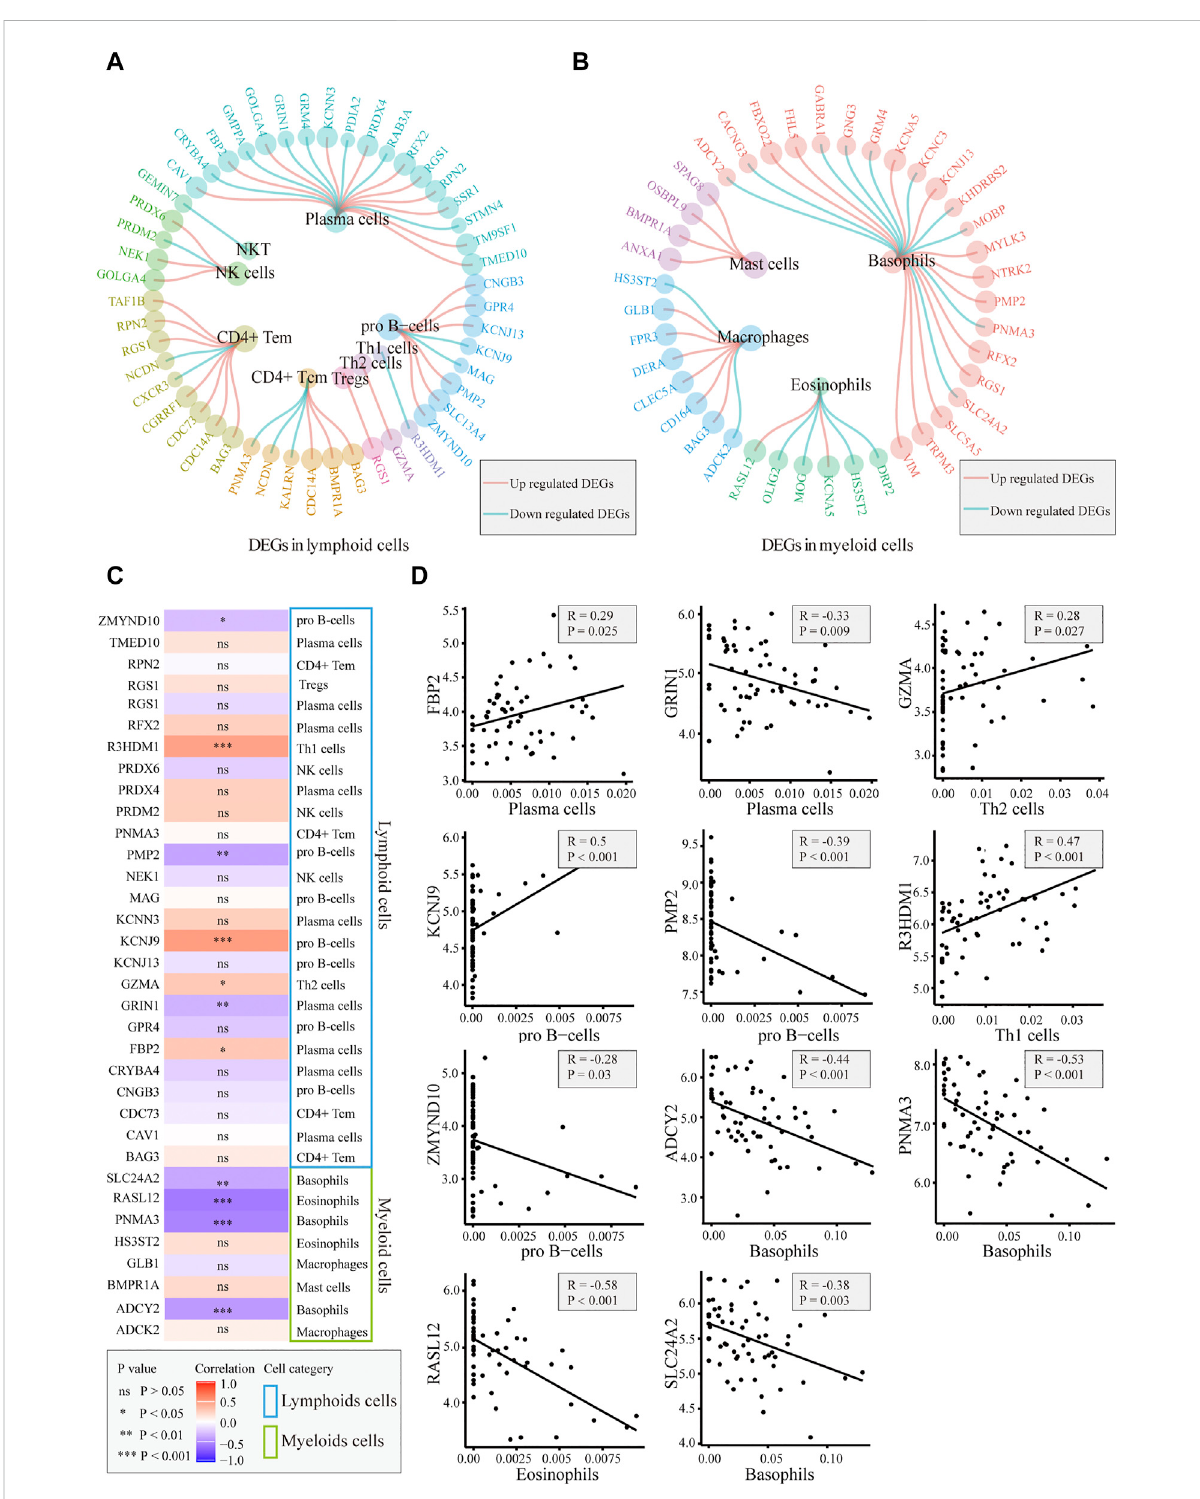
FIGURE 4 Correlation between immune cells and related gene detection. (A) . Differentially expressed marker genes in lymphoid cells. (B) . Differentially expressedmarkergenesinmyeloidcells. (C) .Heatmapofthecorrelationbetweendifferentiallyexpressedmarkergenesandcorrespondingimmune cells. (D) .Plotofthecorrelationbetweendifferentiallyexpressedmarkergenesandcorrespondingimmunecells: FBP2 , GZMA , KCNJ9 ,and R3HDM1 are positively correlated with the corresponding cells. GRIN1 , PMP2 , ZMYND10 , ADCY2 , PNMA3 , RASL12 , and SLC24A2 were signi fi cantly negatively correlated with the corresponding